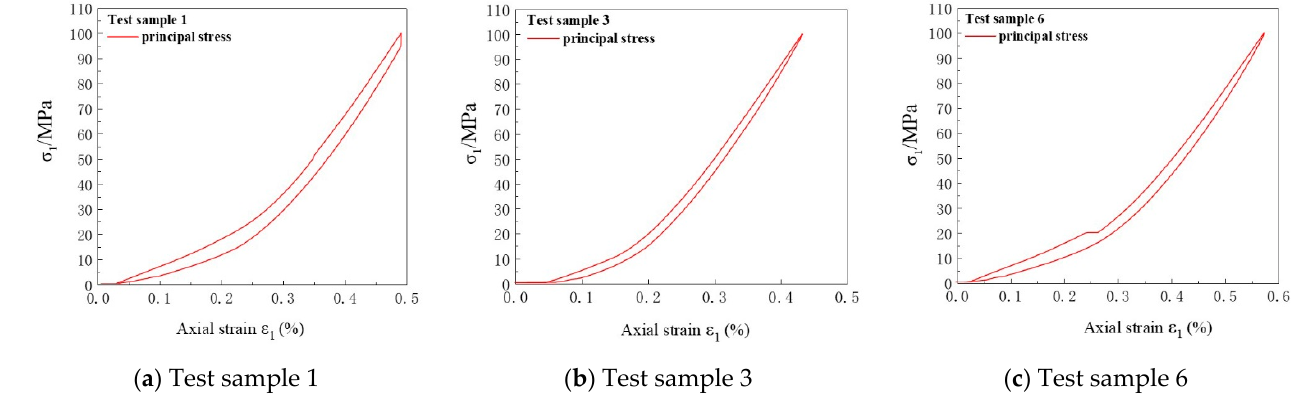
Figure 4. Stress–strain curve under pre-cracking damage.